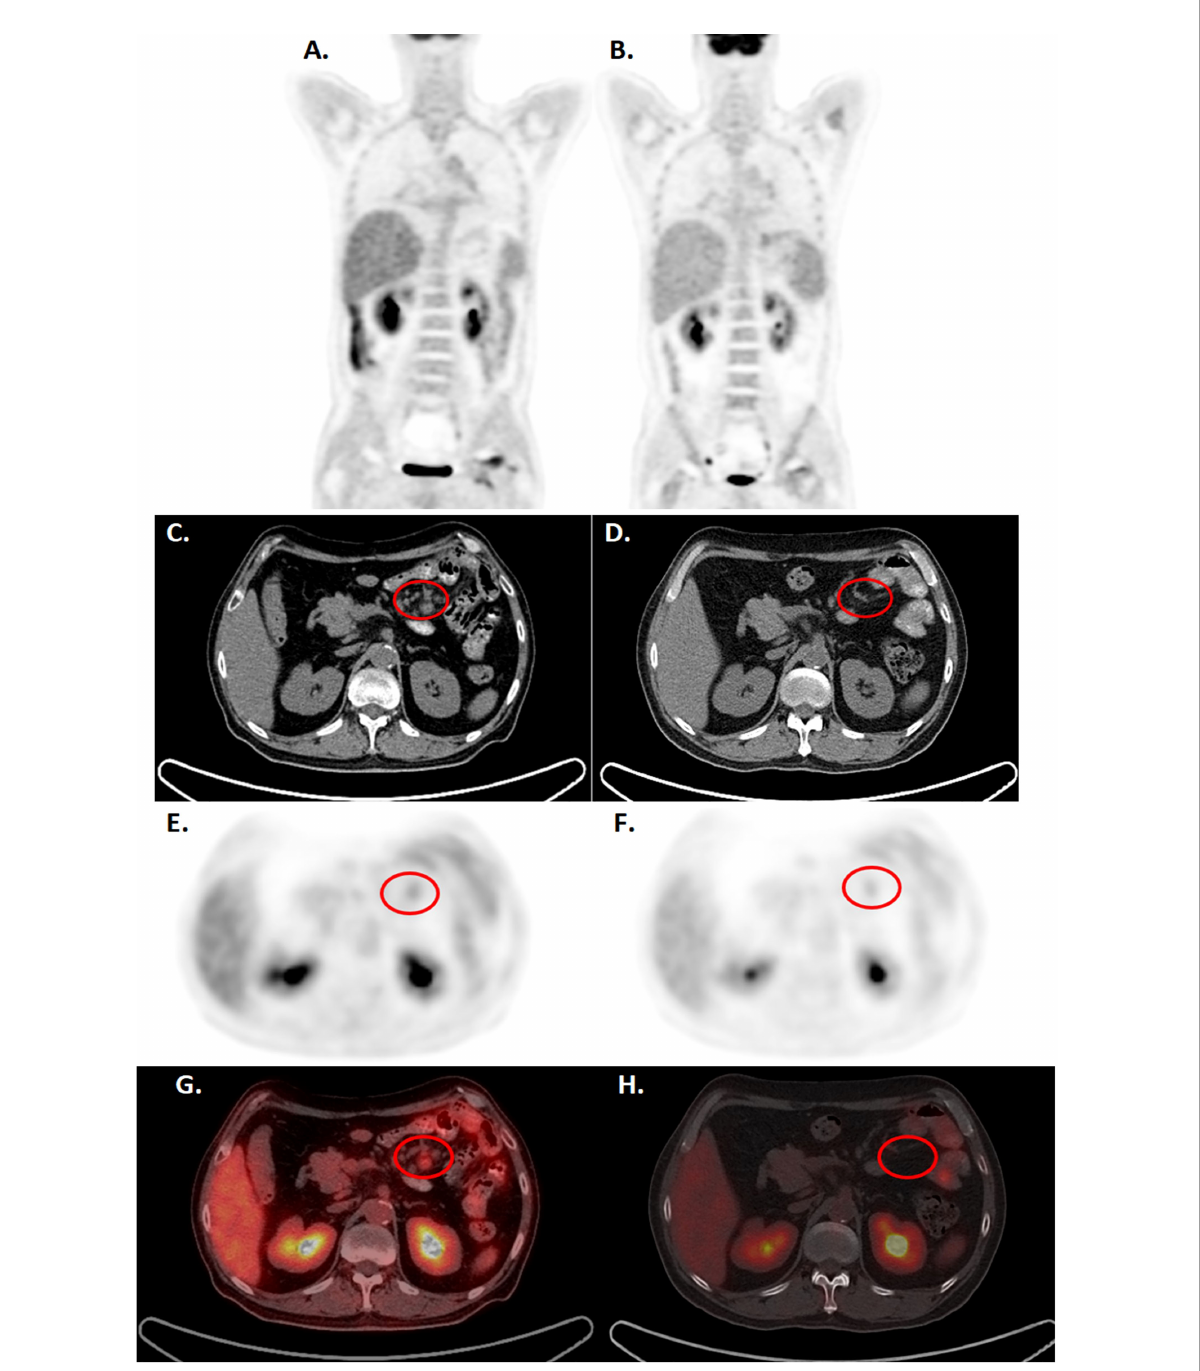
FIGURE 6 CD4-IL15/IL15sushi CAR T cells led to clinical improvements in Patient 3, diagnosed with mesenteric lymphoma, by PET-CT. (A, C, E, G) PET-CT before CD4-IL15/IL15sushi CAR T cell therapy show signi fi cant FDG uptake in mesenteric lymph nodes (circled). The larger retroperitoneal and mesenteric lymphadenopathy measure 2.4*1.7 cm, with the SUVmax of 2.1-5.2 (B, D, F, H) PET-CT 11 weeks after therapy showed reduction of mesenteric lymph node size and FDG avidity. The proto-enlarged lymph node lesions were signi fi cantly reduced or absent from before, with SUVmax of